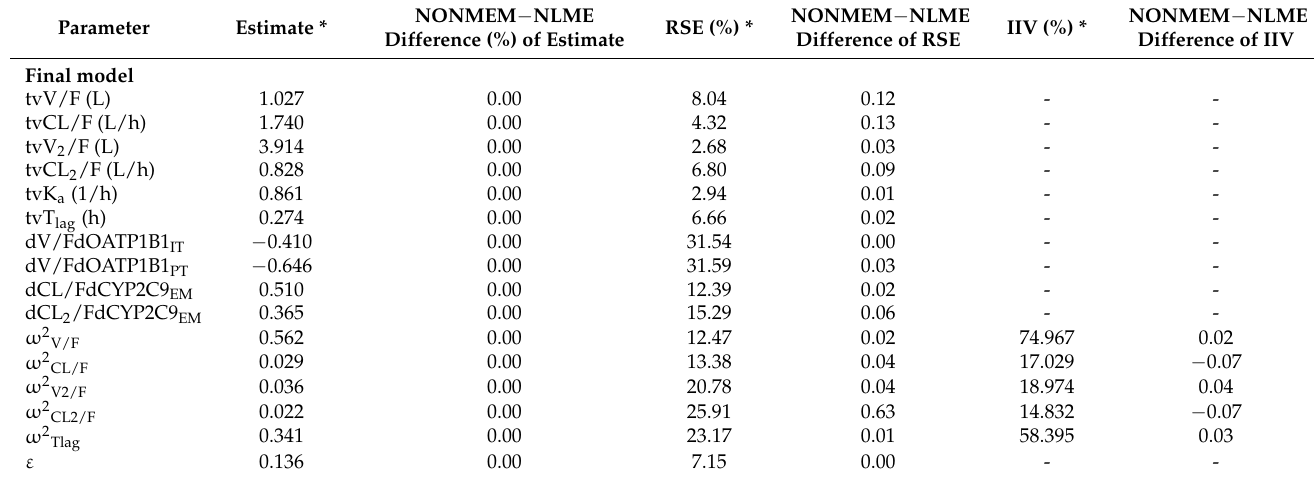
Table 6. Parameter values of the finally established human Pop-PK model for torsemide using NONMEM software and comparison with values from Phoenix